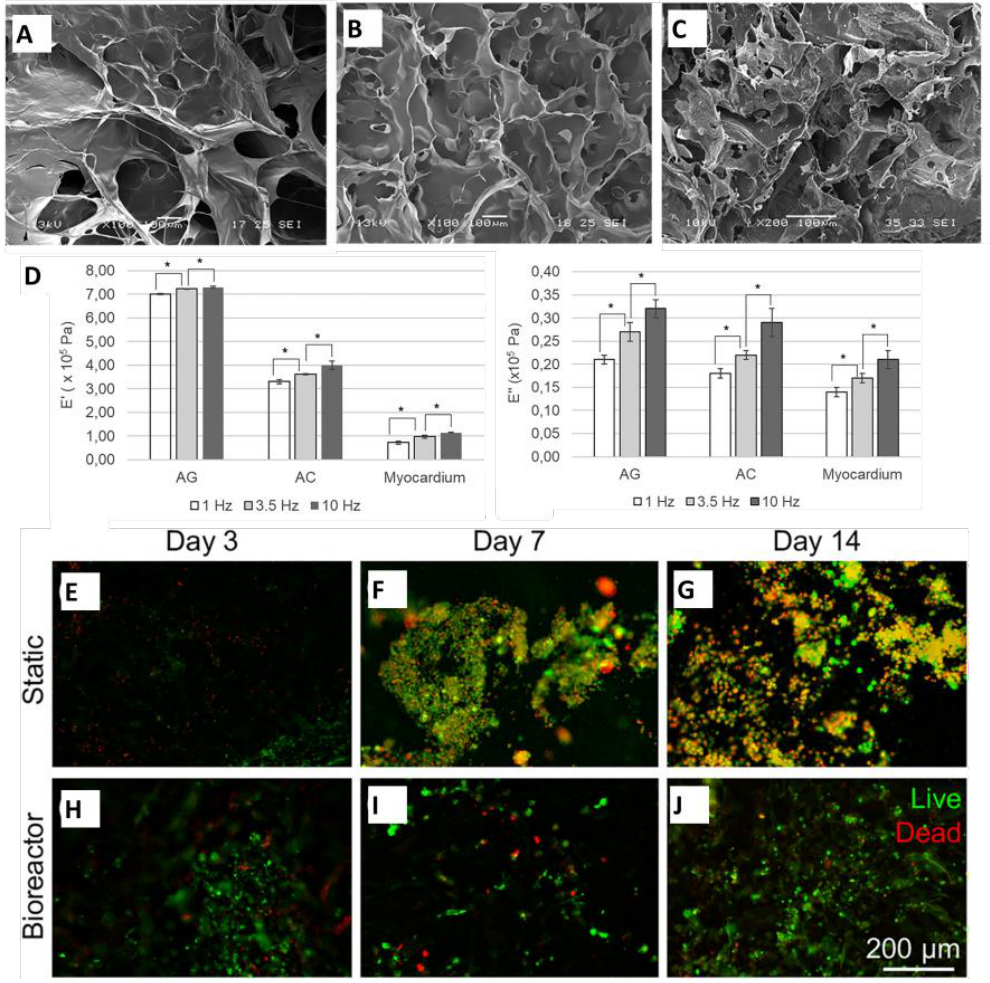
Figure 6. ( A – C ) SEM images (scale: 100 μ m) of the different protein – polysaccharide materials: ( A ) Alginate / gelatin ( B ) Alginate / collagen ( C ) Decellularized porcine myocardium. ( D )